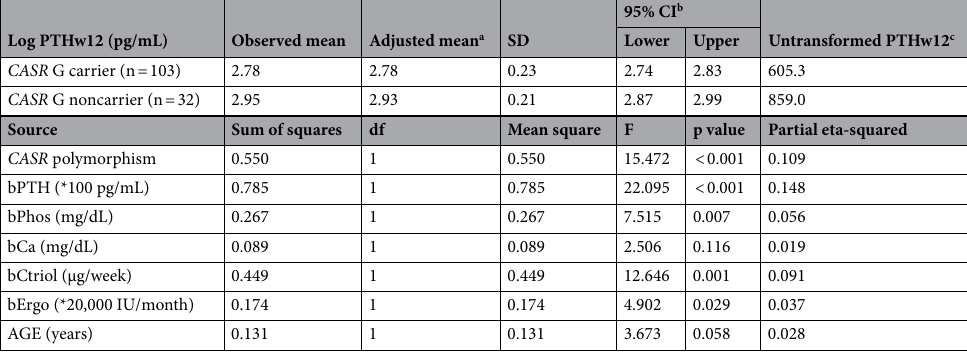
Table 3. ANCOVA results and descriptive statistics for log PTHw12 (n = 135). R 2 = 0.382 (adjusted R 2 = 0.348); The homogeneity of regression slopes was evaluated by conducting a preliminary univariate ANOVA, which indicated that there were no significant interactions between each of the tested covariates and the CASR polymorphisms (all p > 0.05). Levene’s test reveals equal variances for each group of measurements, F(1, 133) = 1.442, p = 0.232. Log PTHw12 in years = 2.358—0.152 (if G carrier) + 0.023 (bPTH in *100 pg/mL) + 0.33